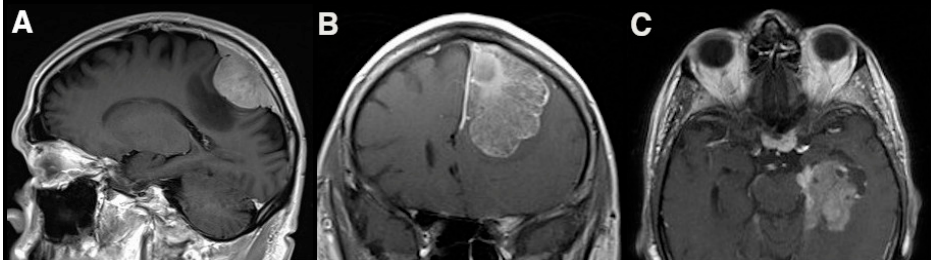
Figure 1. Three meningiomas of the Tübingen Meningioma Cohort are shown as representative ex- amples of MR-Imaging characteristics that have been associated with invasive growth (peritumoral edema ( A ); irregular contrast enhancement ( B ); irregular tumor shape ( C )). In all three cases histo- pathological evidence of invasive growth into CNS parenchyma was detected.